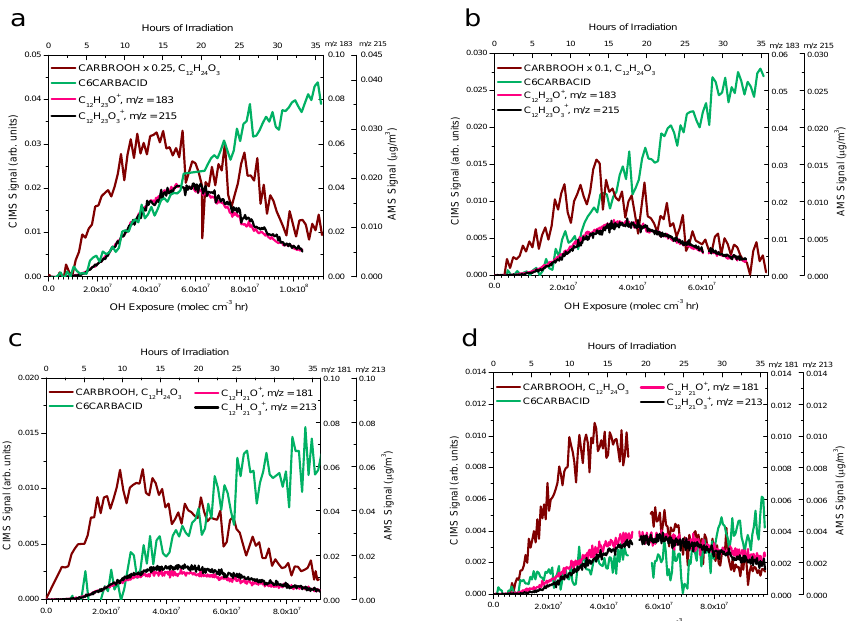
Fig. 8. Gas-phase trends of the generated carbonyl hydroperoxide (CARBROOH) and C 6 carboxylic acid (C6CARBACID) as monitored by the CIMS and the CARBROOH and its derived PHA in the particle phase for (a) n -dodecane, (b) 2-methylundecane, (c) hexylcy- clohexane, and (d) cyclododecane. CARBROOH and its PHA are tracked by AMS ions C 12 H 23 O + and C 12 H 23 O + for n -dodecane and 3 2-methylundecane, and by C 12 H 21 O + and C 12 H 21 O + for hexylcyclohexane and 3